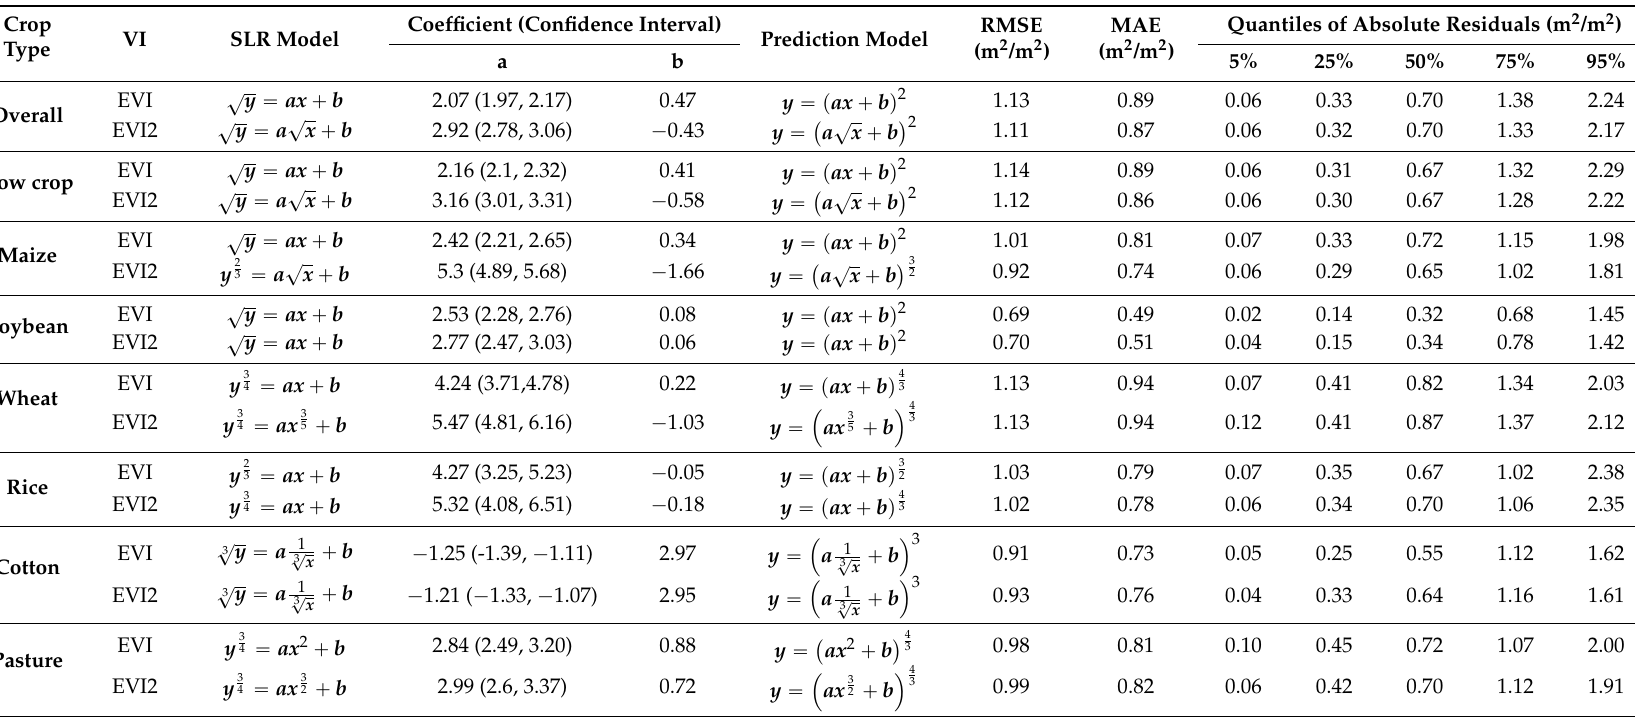
Table 3. LAI-EVI (Enhanced Vegetation Index) and LAI-EVI2 relationships ( LAI “ f p VI q ) based on data transformation and simple linear regression (SLR) with Theil-Sen estimator. The confidence interval of the slope estimates was calculated using analytical solutions by Sen [92]. RMSE: root mean squared error; MAE: Mean Absolute